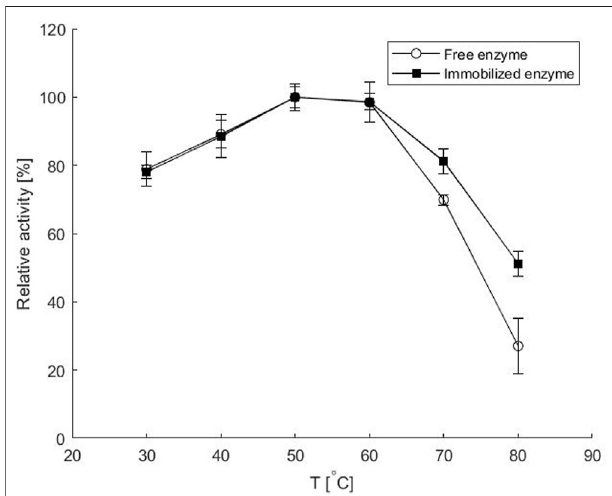
FIGURE 5 | Relative activity of the free and the immobilized enzyme at various temperatures as compared to the reaction rate at 50 ° C. Experiments with immobilized enzyme were performed in a microreactor at 50 μ L min − 1 fl ow rate, while the reaction rate with free enzyme was determined using standard batch enzyme activity measurement. Error bars indicate standard deviations of triplicates.